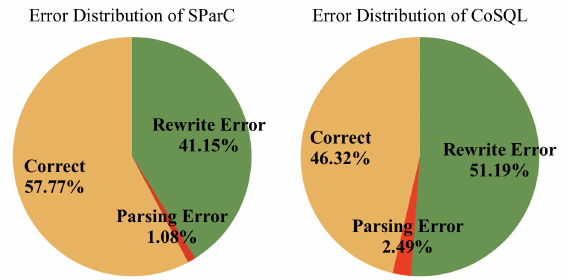
Figure 5. Distribution of the error